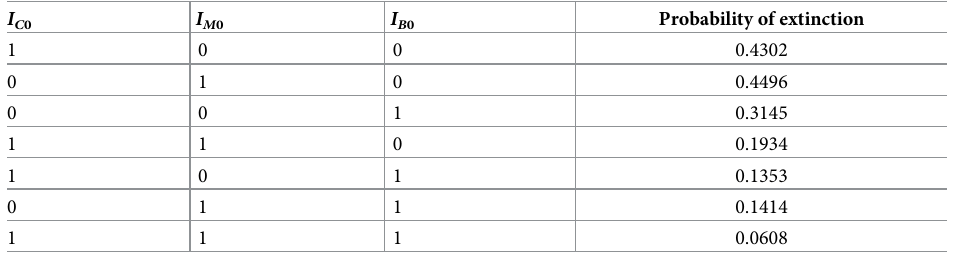
Table 2. Extinction probabilities for various initial conditions using parameters fitted to deterministic model. Col- umns represent the initial number of infections in enzootic vector ( I C 0 ), bridge vector ( I M 0 ), and bird ( I B 0 ) populations and the corresponding probability of extinction in the